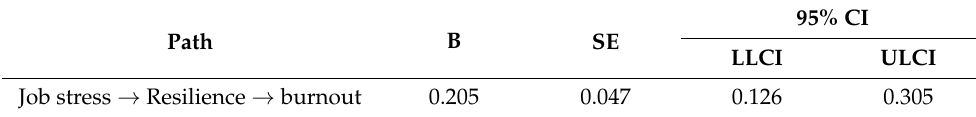
Table 4. Validate the mediated effectiveness of resilience with bootstrapping.